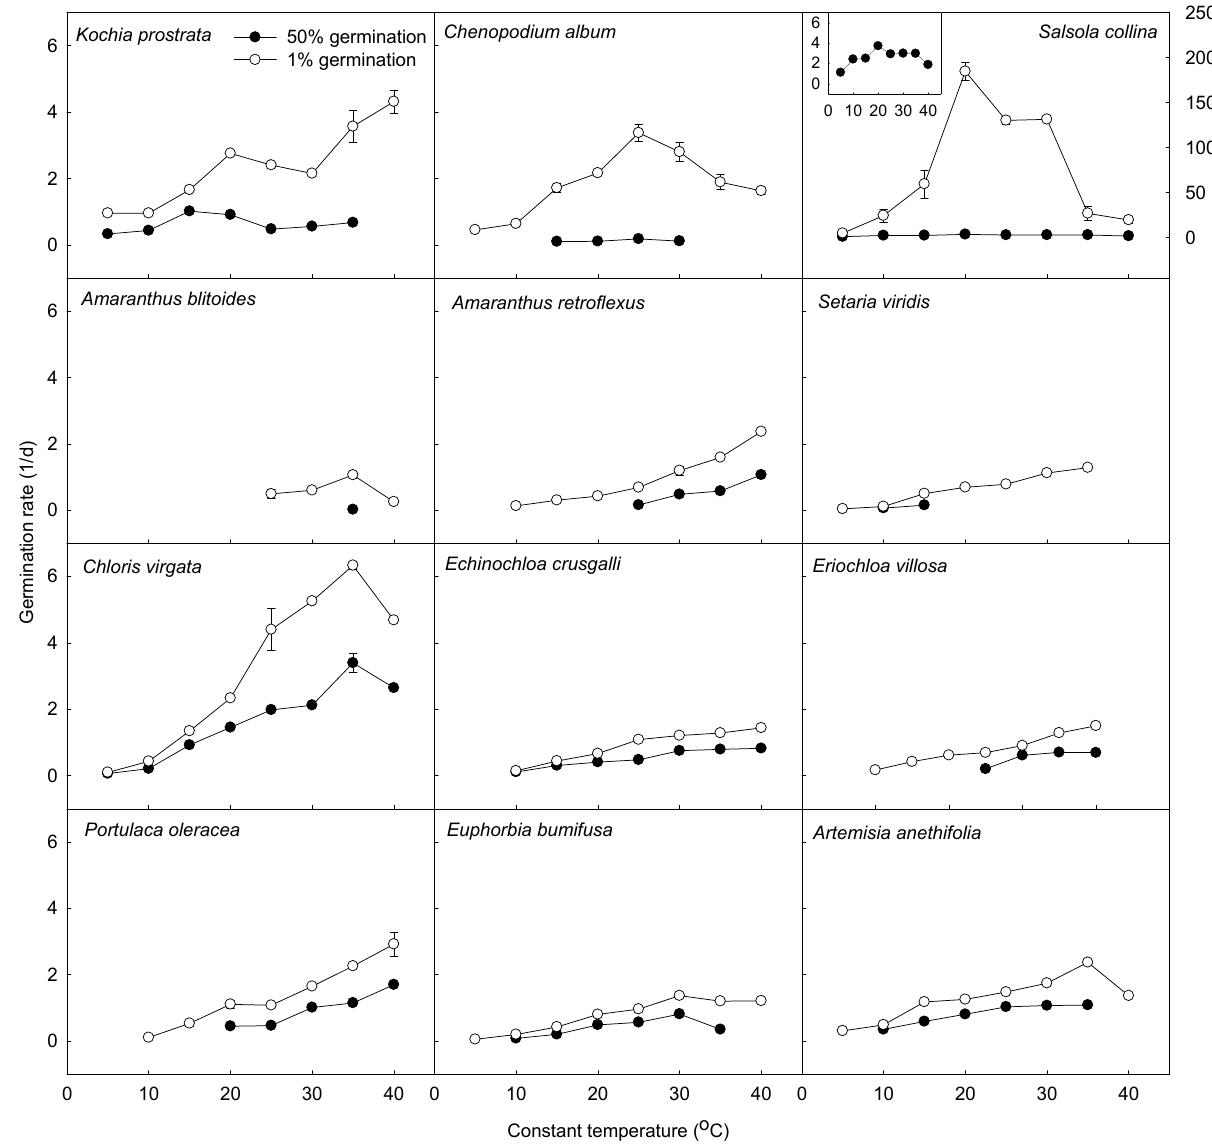
Figure 3. Germination rates of C 4 species for 1% ( ○ ) and 50% ( ● ) germination percentiles at a range of constant temperatures from 5 °C to 40 °C. Bars represent ±SE ( n = 4). For Salsola collina , scaling of y axis was given on the right-hand side; the enlarged figure was for 50% germination